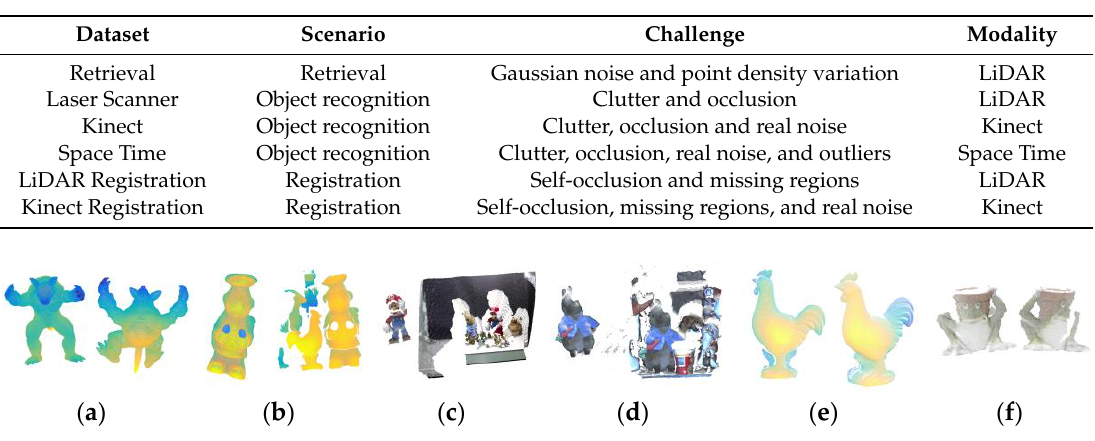
Table 1. Experimental datasets and relevant properties [2 0].